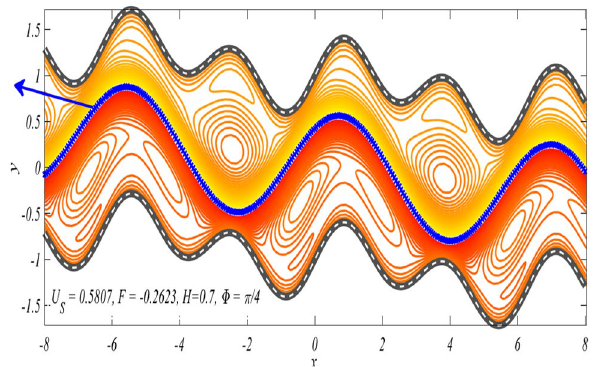
Figure 13. Impact of magnetic field on stream line.